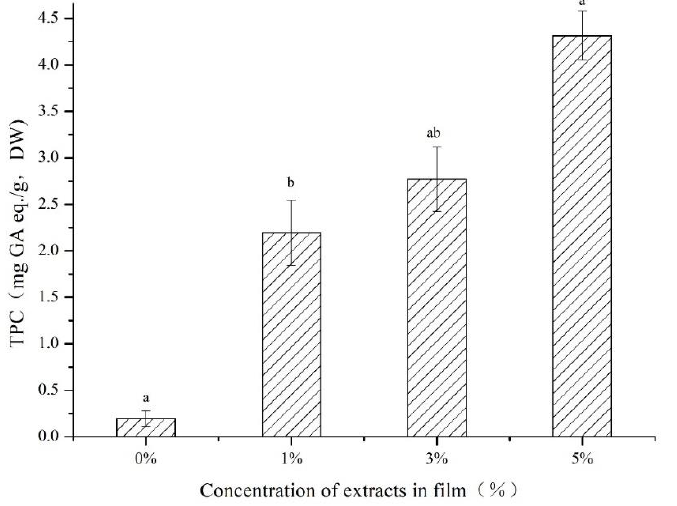
Figure 5. Total phenolic content of the CS/ κ C, 1% CS/ κ C-GSE, 3% CS/ κ C-GSE, and 5% CS/ κ C-GSE films. a, b Values are given as mean ± standard deviation. Different letters in the same line indicate significantly different ( p < 0.05).